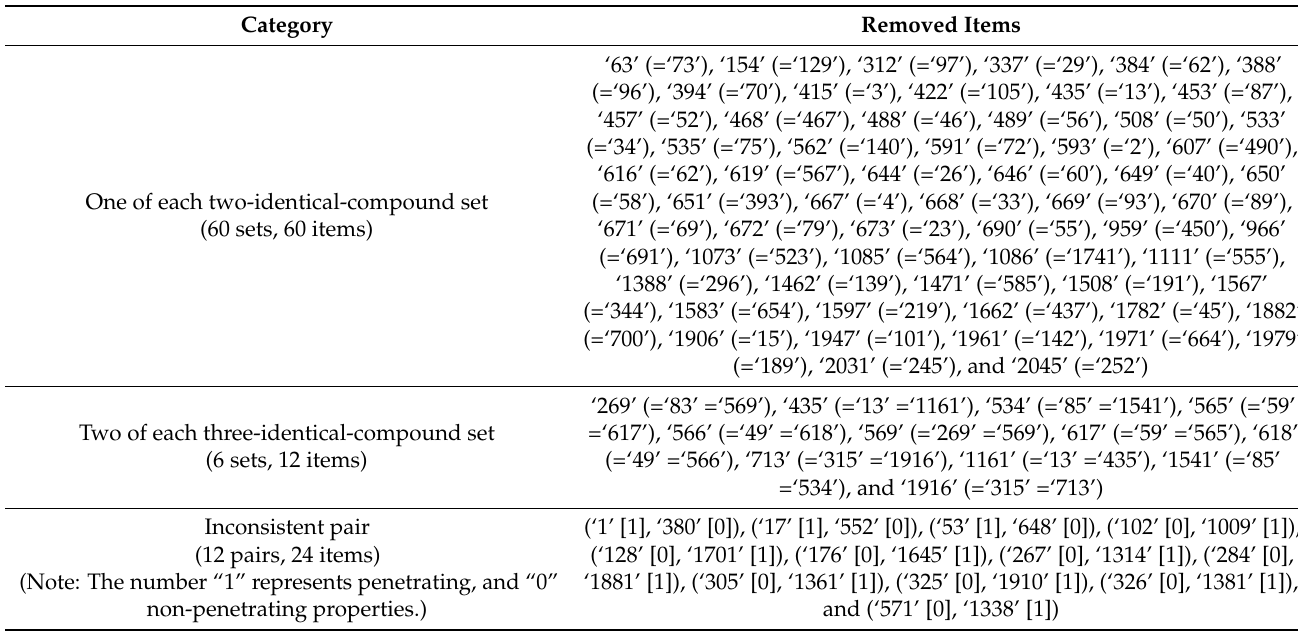
Table 4. List of removed 93